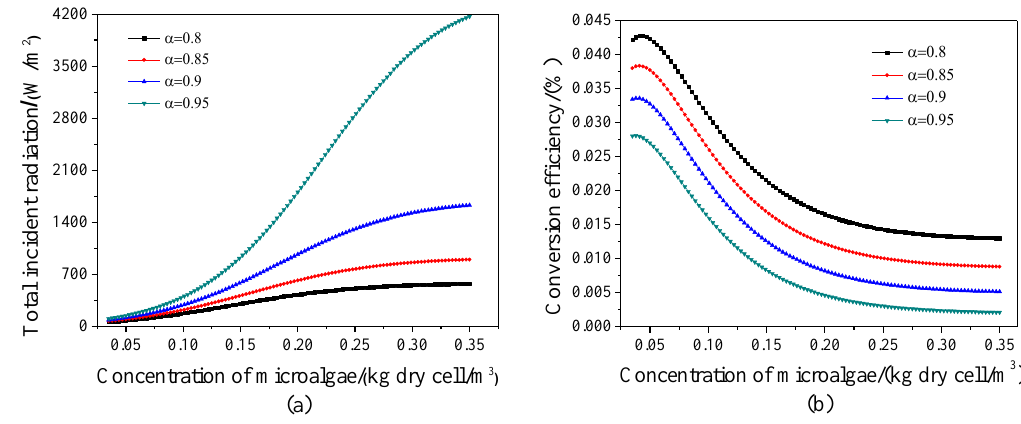
Figure 7. The curves of total incident radiation and total hydrogen production rate varying with the concentration of microalgae at α = 1.